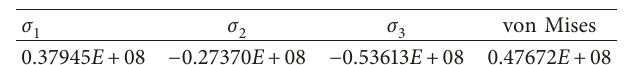
Table 4: The maximum principal stress and maximum von Mises stress of the narrow girder in air inlet side (Pa).